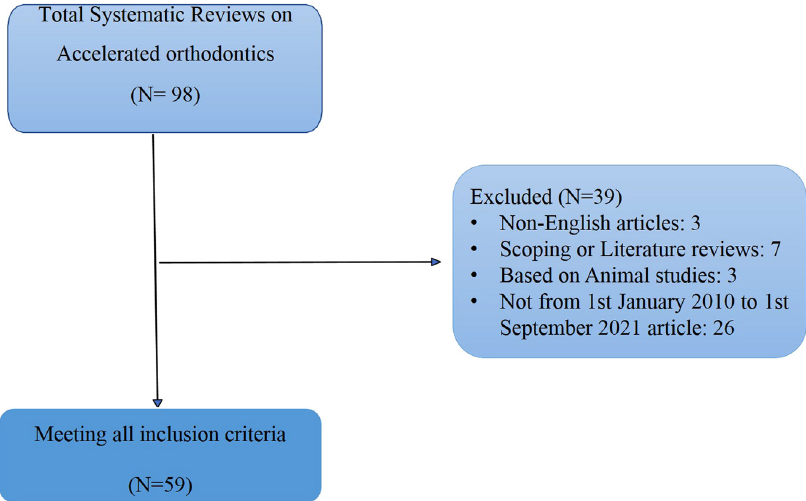
Figure 1. Flowchart for the selection and inclusion of articles assessing spin in accelerated orthodontic tooth movement related systematic review articles and reasons for exclusion.